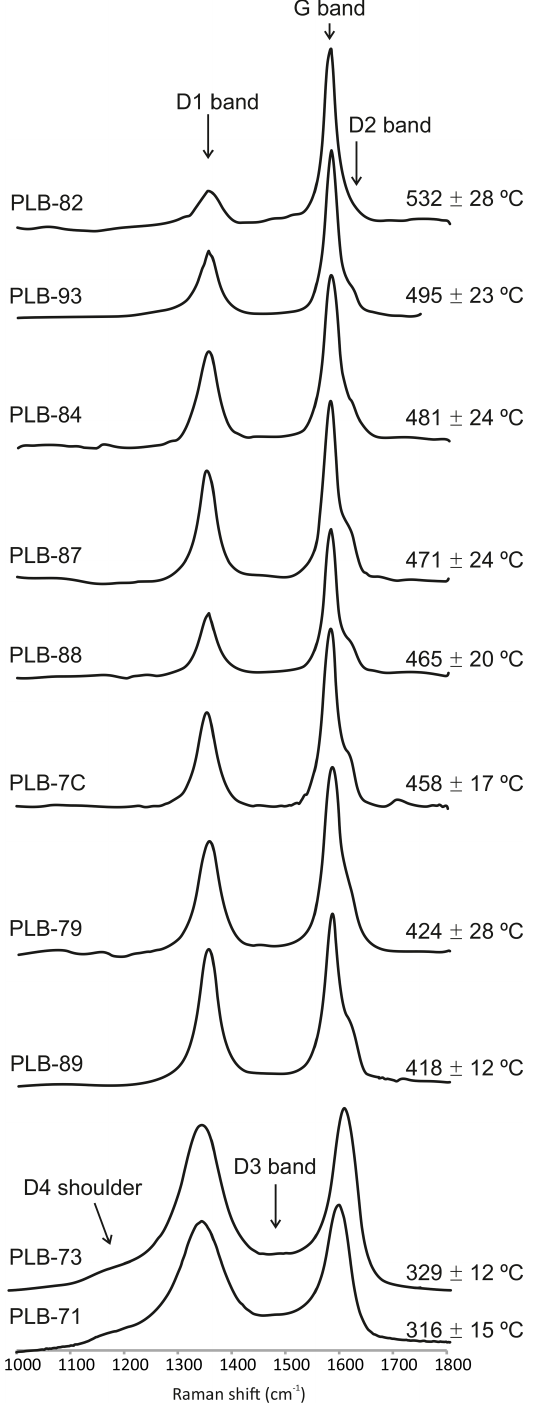
Figure 3. Representative Raman spectra of CM across the Pulo do Lobo domain from low temperature (bottom; Santa Iría Formation) to high temperature (top; lower formations) including the average maximum temperatures ( ◦ C) for each sample. The vertical scale for spectrum intensity is arbitrary. See Fig. 1 for the sample location and Table 1 and the Supplement for RSCM